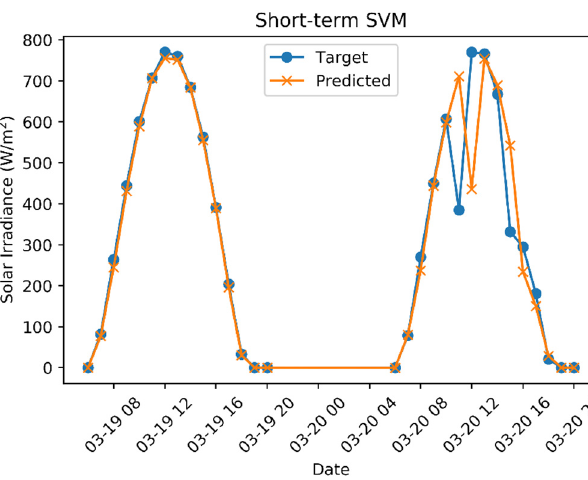
Figure 12. Two days of 1-hour ahead SVM prediction in Boston.